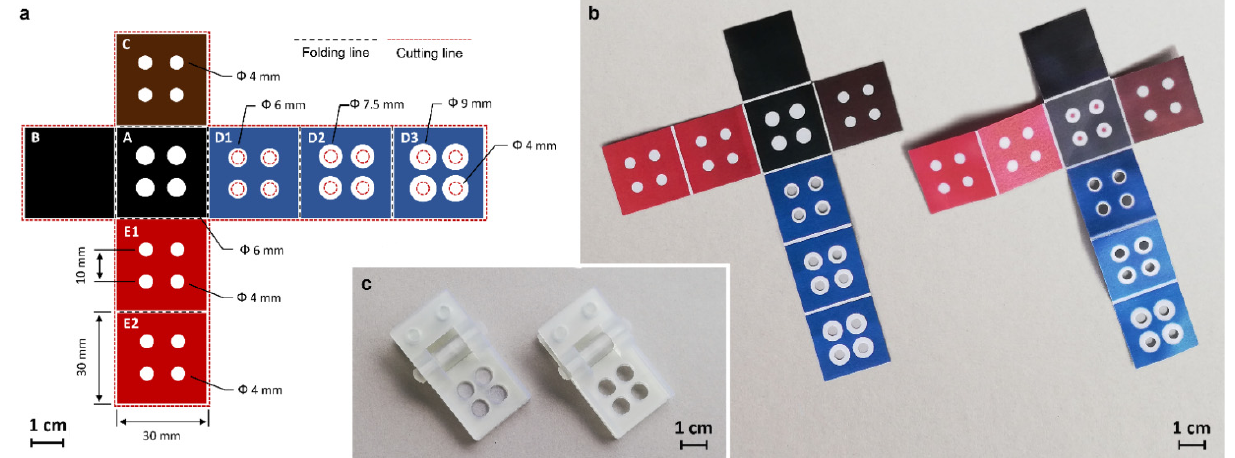
Figure 1. ( a ) Design of the hydrophobic areas of the origami µPAD. Black and red dashed lines represent folding lines (created by a manual rotary perforating blade) and cutting lines, respectively. A: base layer; B: anti-leaching layer; C: immunoreaction layer; D: washing layers; E: CL detection layers. ( b ) Images of the origami µPAD just after cutting of excess paper ( left ) and upon loading and air-drying of reagents and OVA-MBs ( right ). ( c ) Images of the spring-loaded 3D-printed holding clips one equipped with magnets and used for loading of OVA-MBs in the µPAD ( left ) and one without magnets and employed in the assay procedure ( right ). The scale bars represent 1 cm.